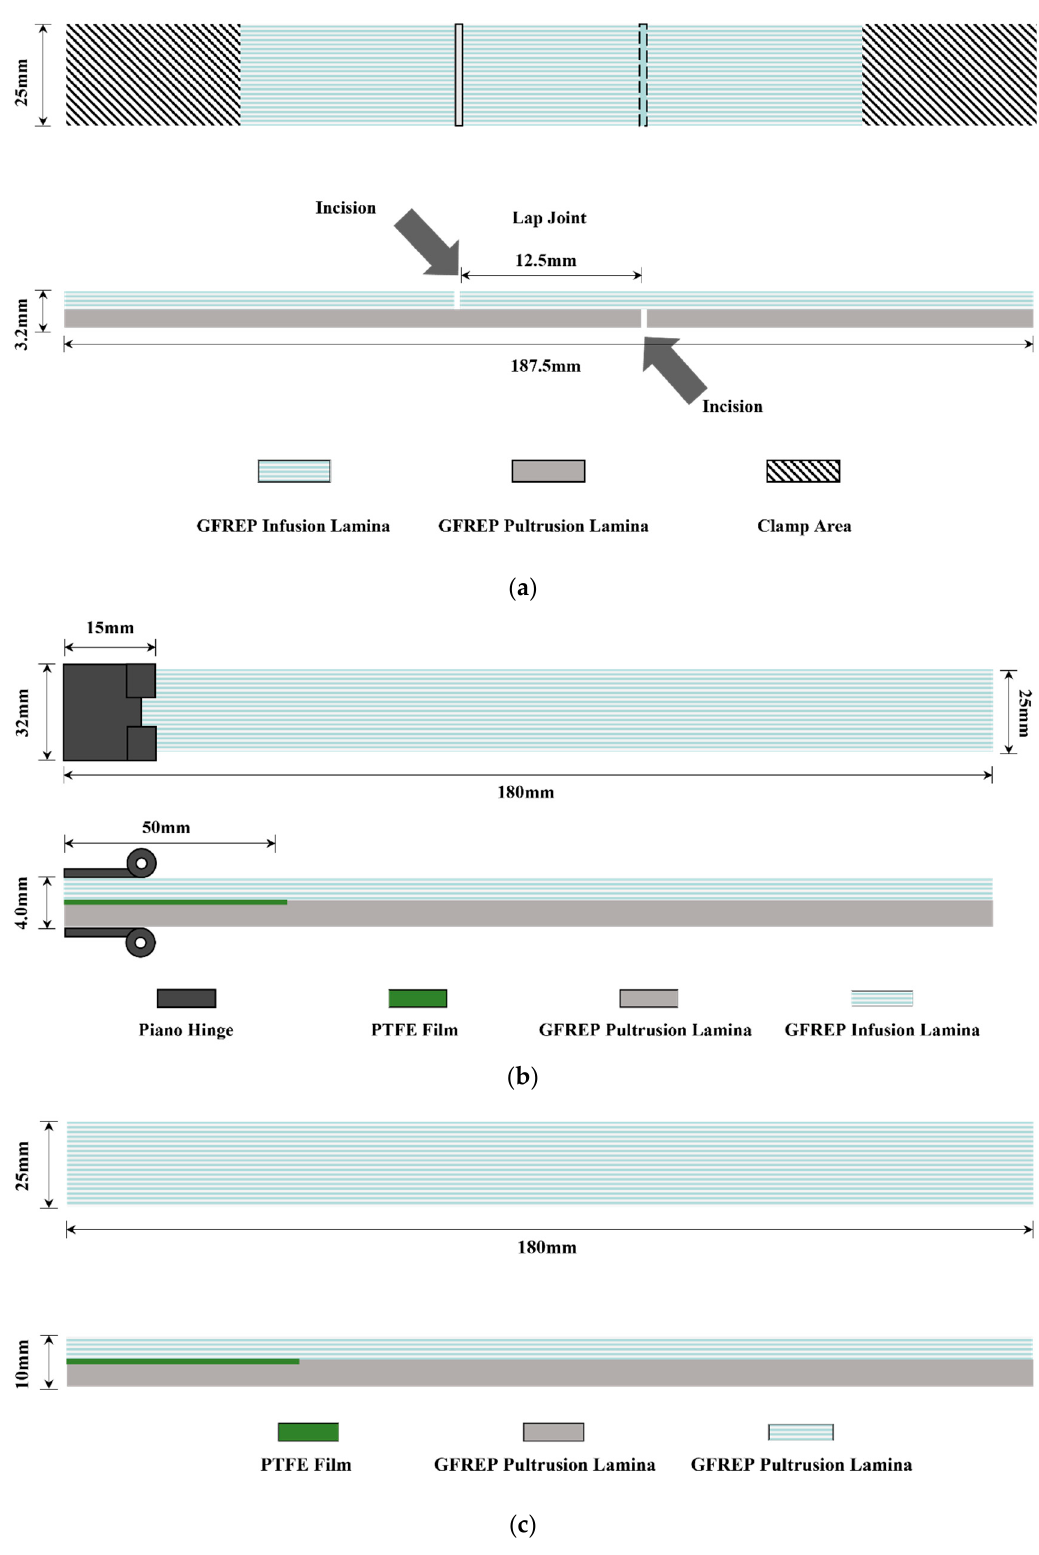
Figure 5. Sample diagrams: ( a ) diagram of the tensile and shear strength; ( b ) diagram of the double cantilever beam; ( c ) diagram of the end-notched flexure. The tensile shear test is carried out in strict accordance with ASTM D1002-10, and the bonding strength between the GF/EP pultruded sheet and infusion plate was